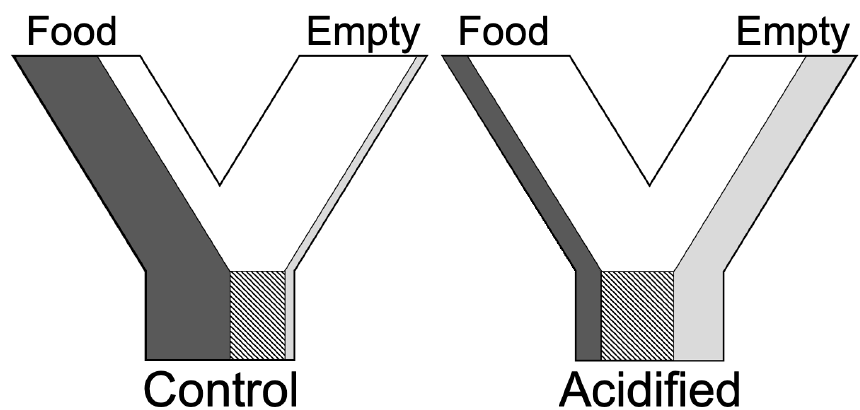
Figure 3. Y-maze schematic diagrams showing the relative proportions of snails that chose the food side of the maze in control and acidified conditions. Dark grey shows the proportion of snails that chose the food, the hashed lines show snails that made no decision, and the light grey shows snails that chose the empty chamber. By combining data from all three sets of experiments (Total control n = 69, acidified n = 79), it is clear that the vast majority of snails choose food in control conditions (60% food, 9% empty, 33% no decision), while more choose the empty side of the maze under acidified conditions (18% food, 32% empty, 51% no decision).